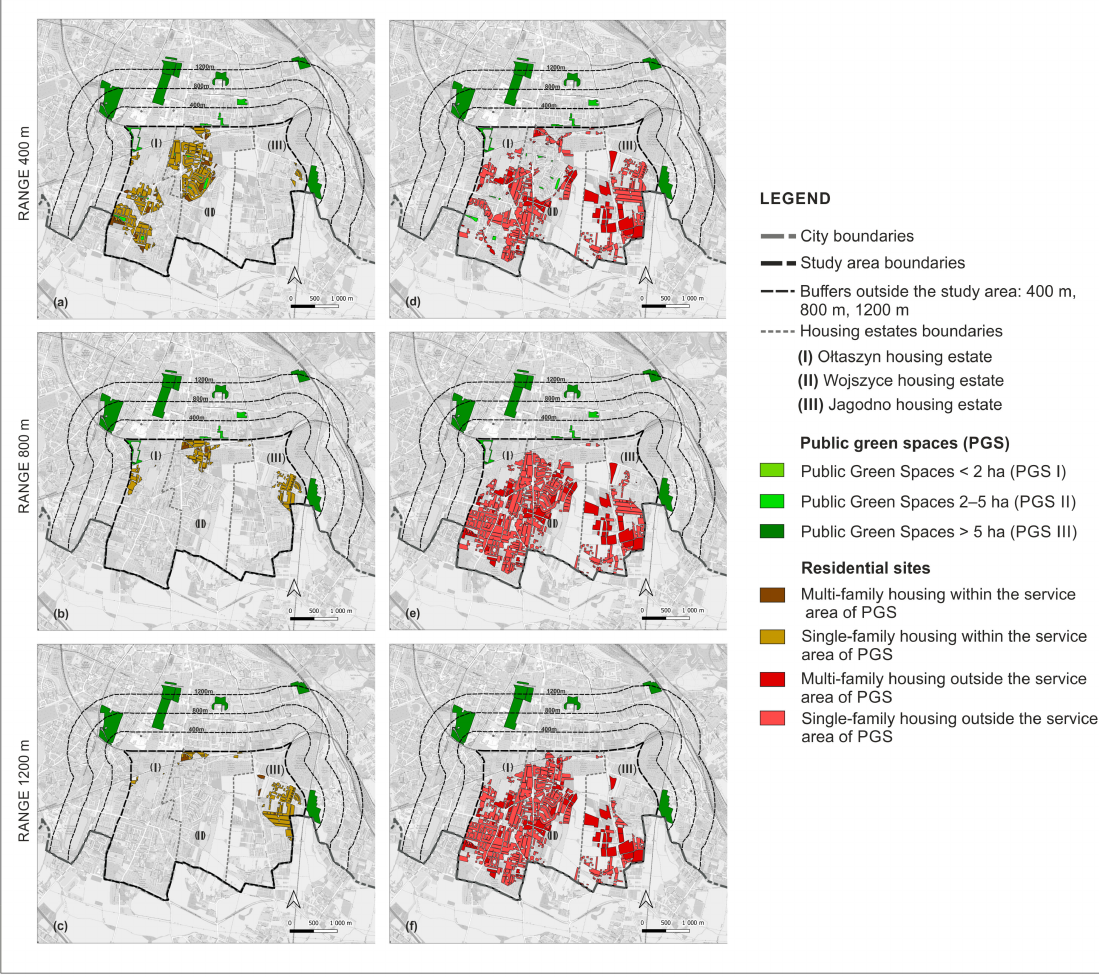
Figure 7. Residential sites within the PGS service areas and outside of them: current state ( a ) Within 400 m; ( b ) within 800 m; ( c ) within 1200 m; ( d ) outside 400 m; ( e ) outside 800 m; ( f ) outside 1200